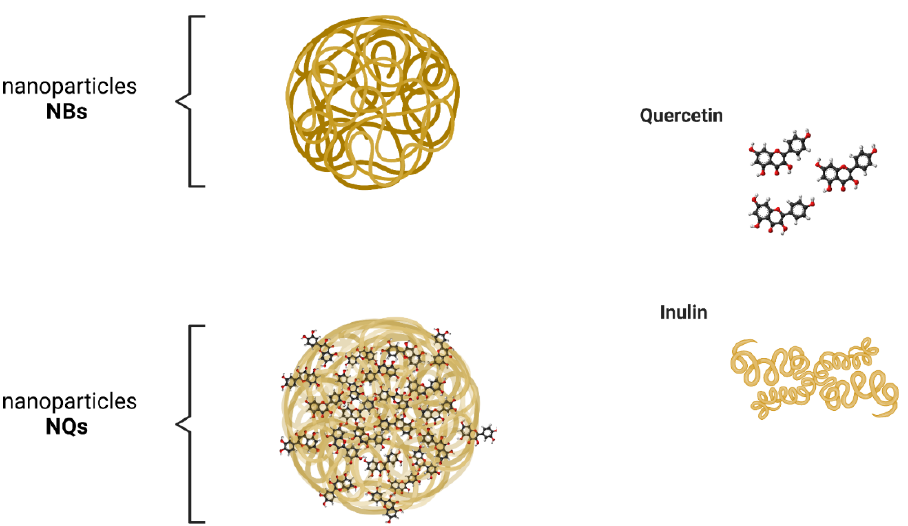
Figure 3. Schematic illustration of synthetized nanoparticles. NBs are the potential structure of unloaded inulin nanoparticles. NQs represents the potential structure of inulin nanoparticles loaded with quercetin by spray drying.